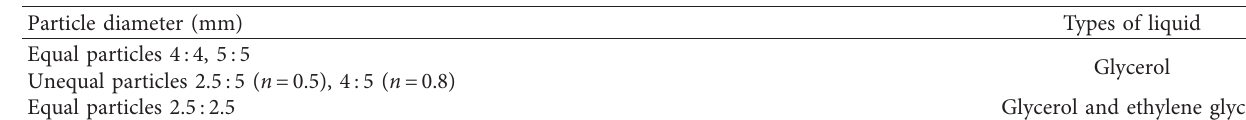
Particle diameter